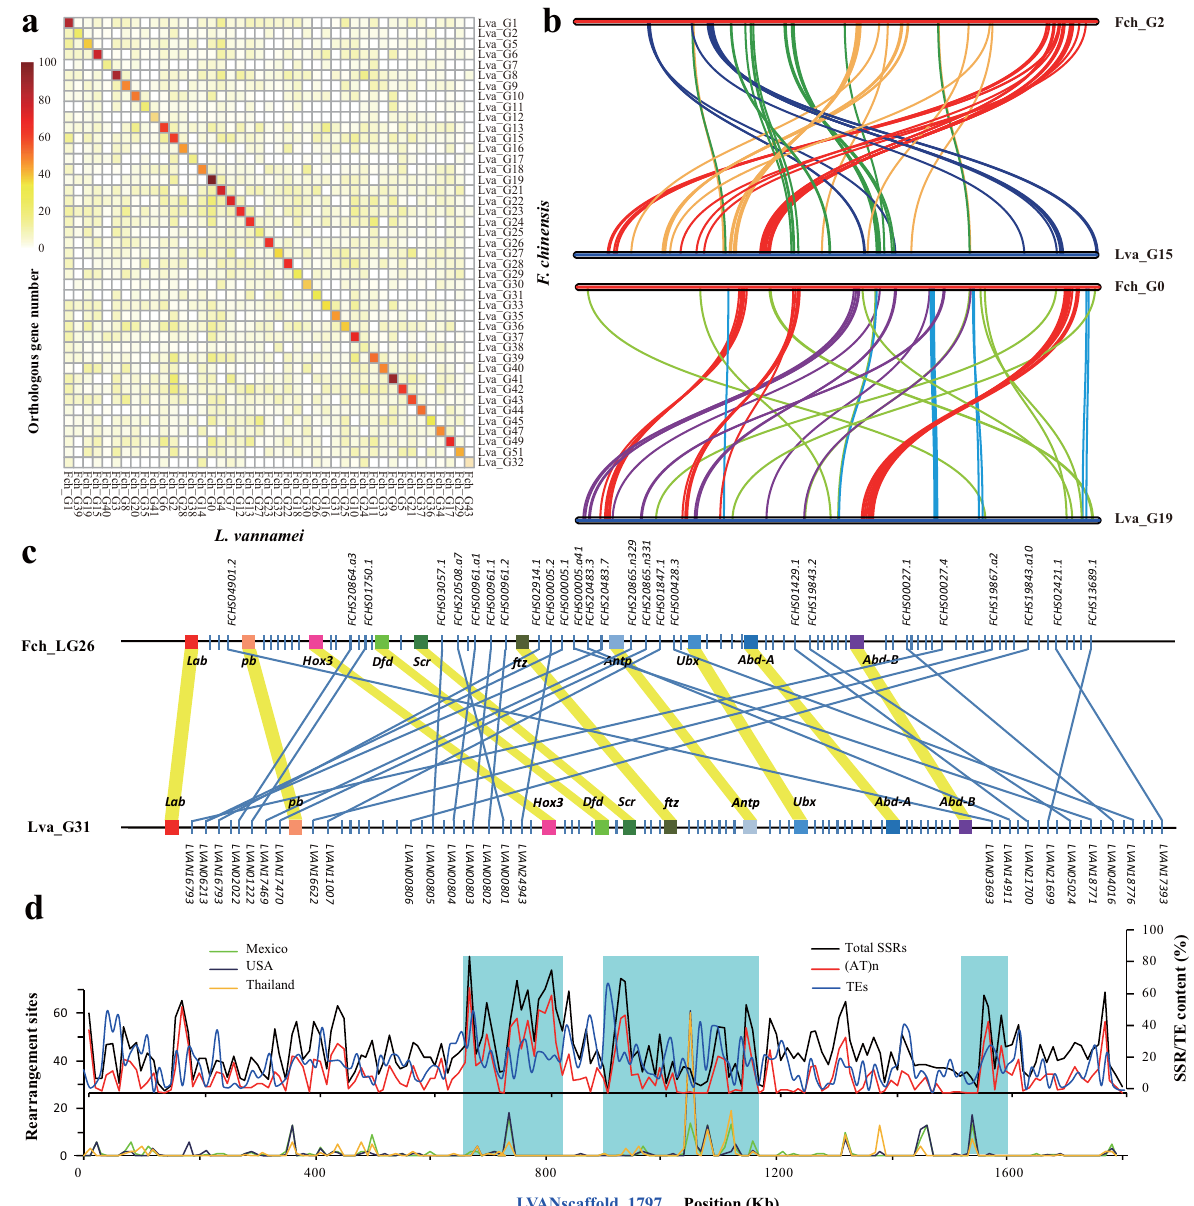
Fig. 3 Intrachromosomal rearrangement in penaeid shrimp genomes. a Heatmap of the orthologous gene numbers in each pair of chromosomes from the two shrimp genomes. b Intrachromosomal rearrangement between the homologous chromosomes of the two shrimp genomes. c Synteny of Hox genes and neighboring genes on the homologous chromosomes of the two shrimp species. d Relationship between rearrangement sites and SSRs. The rearrangement sites were calculated according to the paired-end read (Illumina 170 bp libraries) mapping results. When the distance between the paired mapping reads was longer than 50 kb, the site considered a candidate rearrangement site. The number of rearrangement sites in a window of 10 kb was calculated and compared between the shrimp used for genome sequencing and other populations of L. vannamei (Mexico, USA, and Thailand). The blue boxes show areas that have high chromosomal rearrangements and low SSR content, but sharp peaks of high SSR content